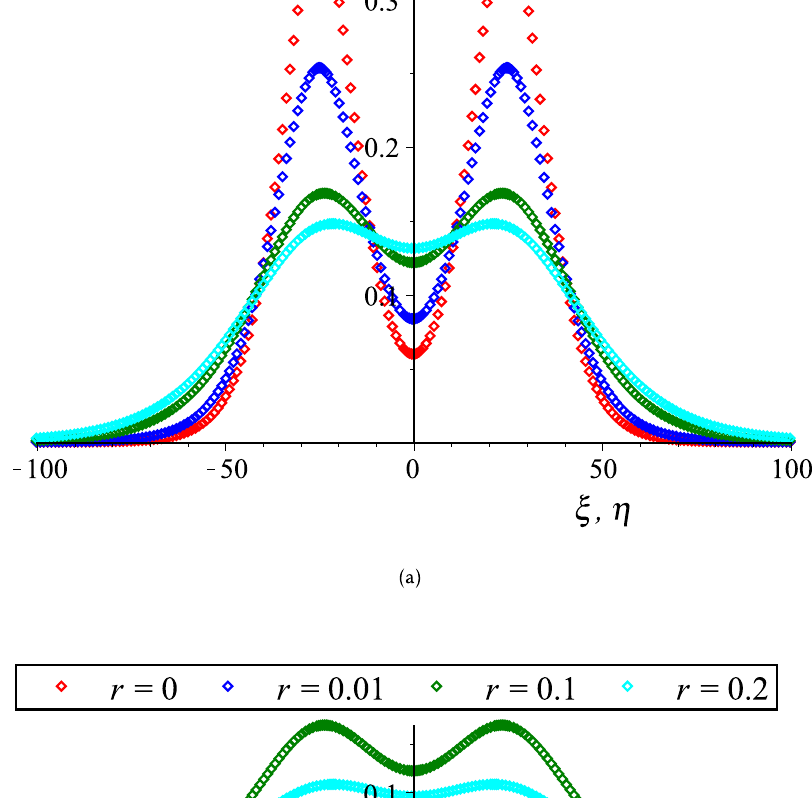
φ ( 1 ) = φ ( 1 ) l + φ ( 1 ) r for different values of ( a ) q ( r = 0.1) and ( b ) r ( q = 3). The (cid:31) (cid:30)